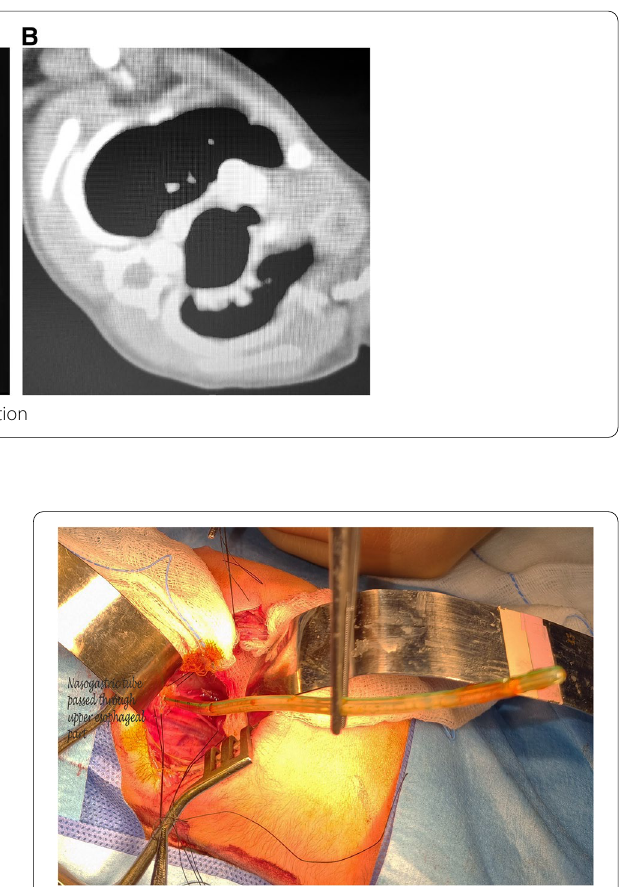
Fig. 6 NGT passing through the proximal